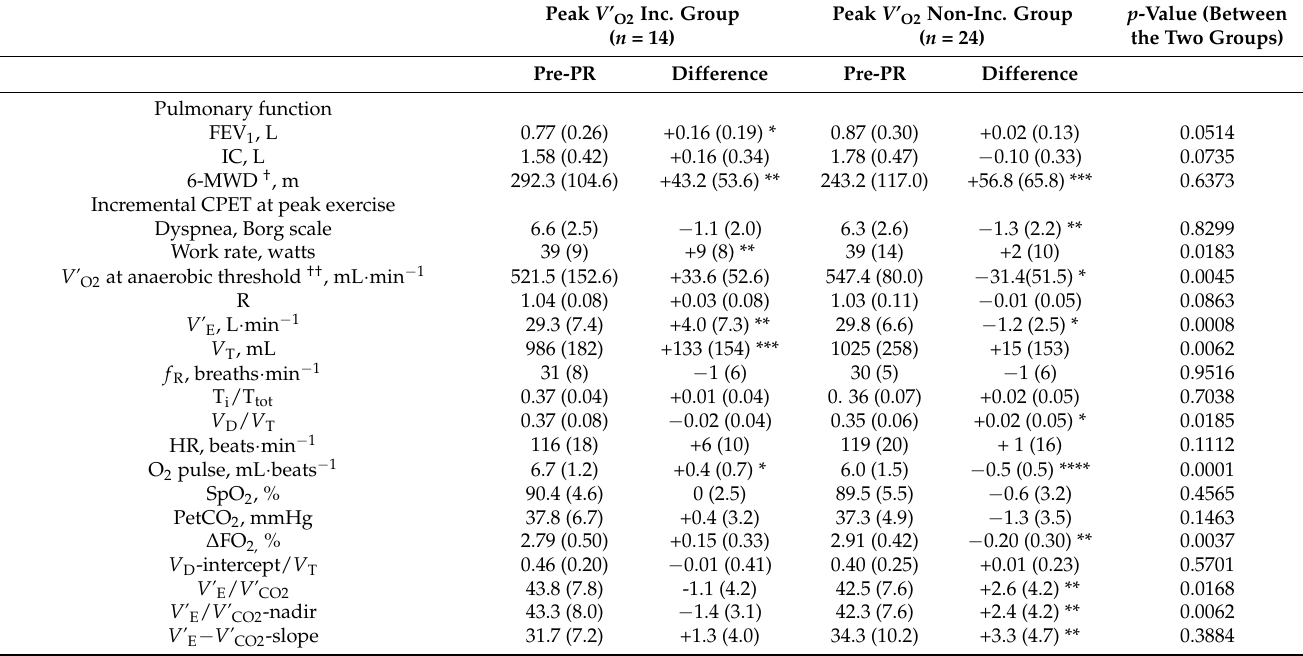
Table 2. Changes in cardiopulmonary variables after pulmonary rehabilitation in the peak V’ O2 increase and peak V’ O2 non-increase groups ( n = 38). Peak V’ O2 Inc. Group Peak V’ O2 Non-Inc. Group ( n = 14) ( n =